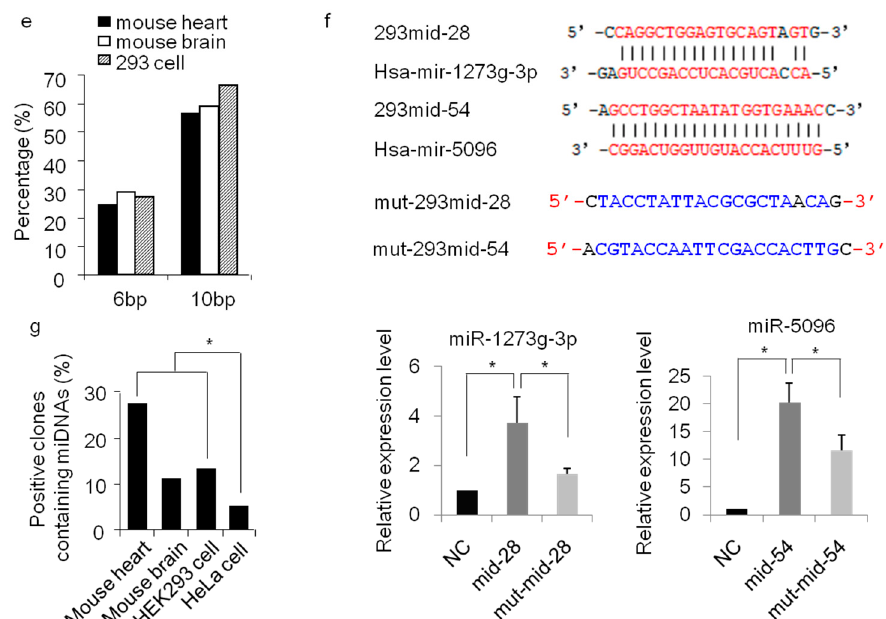
Figure 5. Interaction between microDNAs and microRNAs. ( a – c ) Sequence alignments between SSLmicroDNAs and microRNAs in HEK293 cells ( a ), mouse hearts ( b ) and mouse brains ( c ) were analyzed using the bioinformatics program RNAhybrid. ( d ) Analysis of the free energy (mfe) in microDNA-microRNA alignments. The unit of energy was –kcal/mol. ( e ) Analysis of the microDNA-microRNA sequence alignment. 6 bp represented 6 bp- or more than 6 bp-continuous pairing in the seed region of microRNAs. 10 bp represented 10 bp- or more than 10 bp-continuous pairing in microRNAs. ( f ) Detection of the interaction between microDNAs and microRNAs in cell nucleus. The upper panel showed the sequence alignment we predicted between 293mid-28 and hsa-mir-1273g-3p, as well as 293mid-54 and hsa-mir-5096. The middle panel showed the mutant sequence region in 293mid-28 and 293mid-54. HEK293 cells were transfected with biotinylated 293mid-28 or negative control RNA (NC) or mutant 293mid-28 and then performed with the pulldown system based on interaction between biotin and streptavidin. The levels of miR-1273g-3p were detected by qRT-PCR in the pulldown product. n = 3, * p < 0.05 vs. NC. The combination of 293mid-54 and miR-5096 was analyzed similarly to that of 293mid-28. ( g ) Analysis of SSLmicroDNA yield. The rates of SSLmicroDNA-positive clones relative to the total number of clones during purification were counted. * p < 0.05.